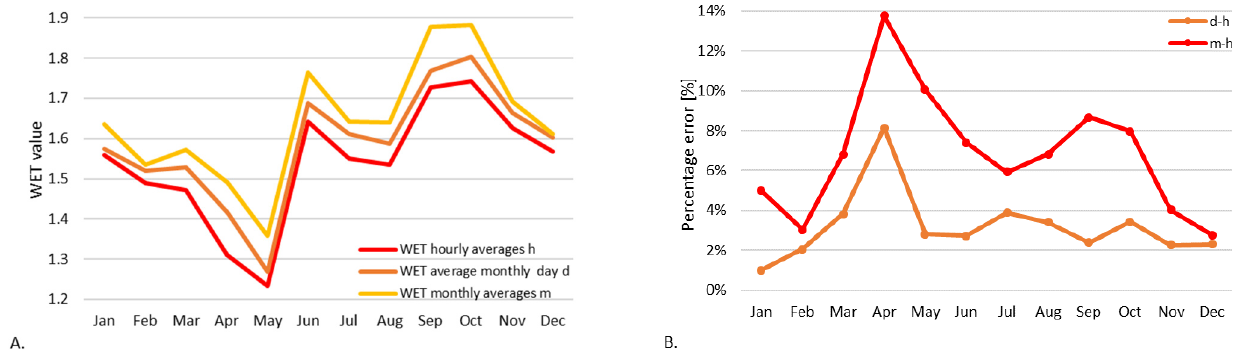
Figure 11. Dubai WET values ( A ) and percentage error ( B ).